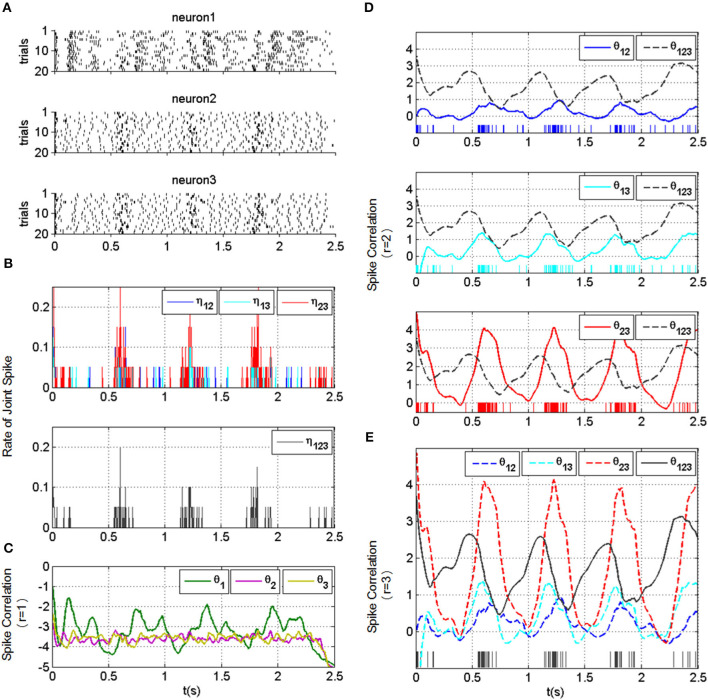
Estimation of spike correlations for acupuncture data evoked by lifting-thrusting reinforcing. (A) Ensemble spike activities. The number of neurons is N = 3 and the number of trials is n = 20. (B) Rates of joint spike: η12, η13, η23, and η123. (C) First-order spike correlations: θ1, θ2, and θ3 (green, pink, and yellow solid lines). (D) Second-order spike correlations: θ12, θ13, and θ23 (blue, cyan, and red solid lines). (E) Third-order spike correlation: θ123 (gray solid line). Raster with different colors at the bottom show the timing of corresponding order synchronous spikes.